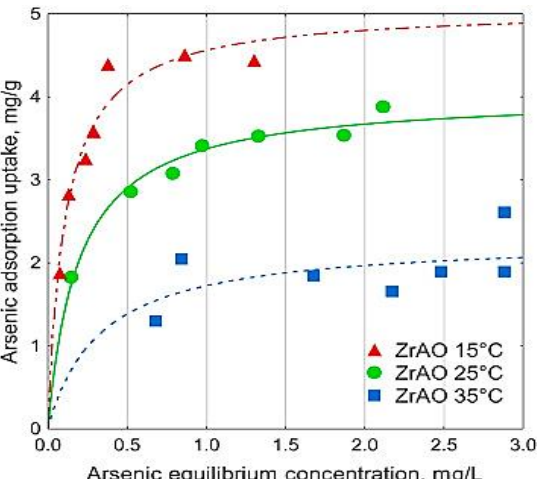
Figure 9. Effect of temperature and initial concentration on adsorption of As (V) into zirconium- activated carbon. Reprinted from Velazquez-Jimenez et al. [56] Copyright 2021 Elsevier.